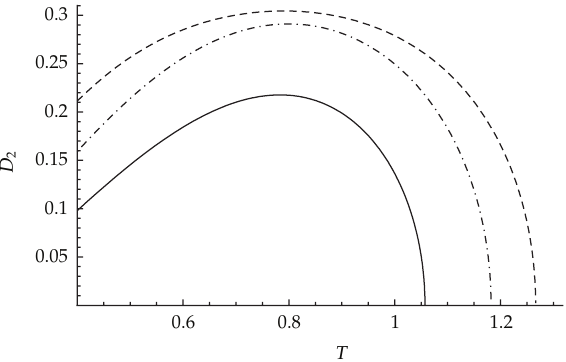
Figure 2: A plot of the order parameter D 2 as a function of temperature T . The charge density is ρ (cid:7) 1. The dashed line corresponds to a magnetic field H (cid:7) 0 . 1, the dash-dot one to H (cid:7) 0 . 2, and the solid one to H (cid:7) 0 . 3. (cid:4) the critical value is H c (cid:7) 0 . 6 (cid:5)